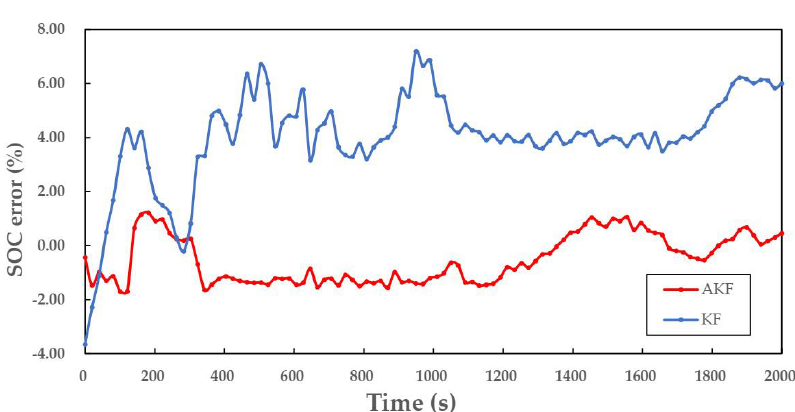
Figure 4. The error of SOC estimate using methods of AH, AKF, and KF.